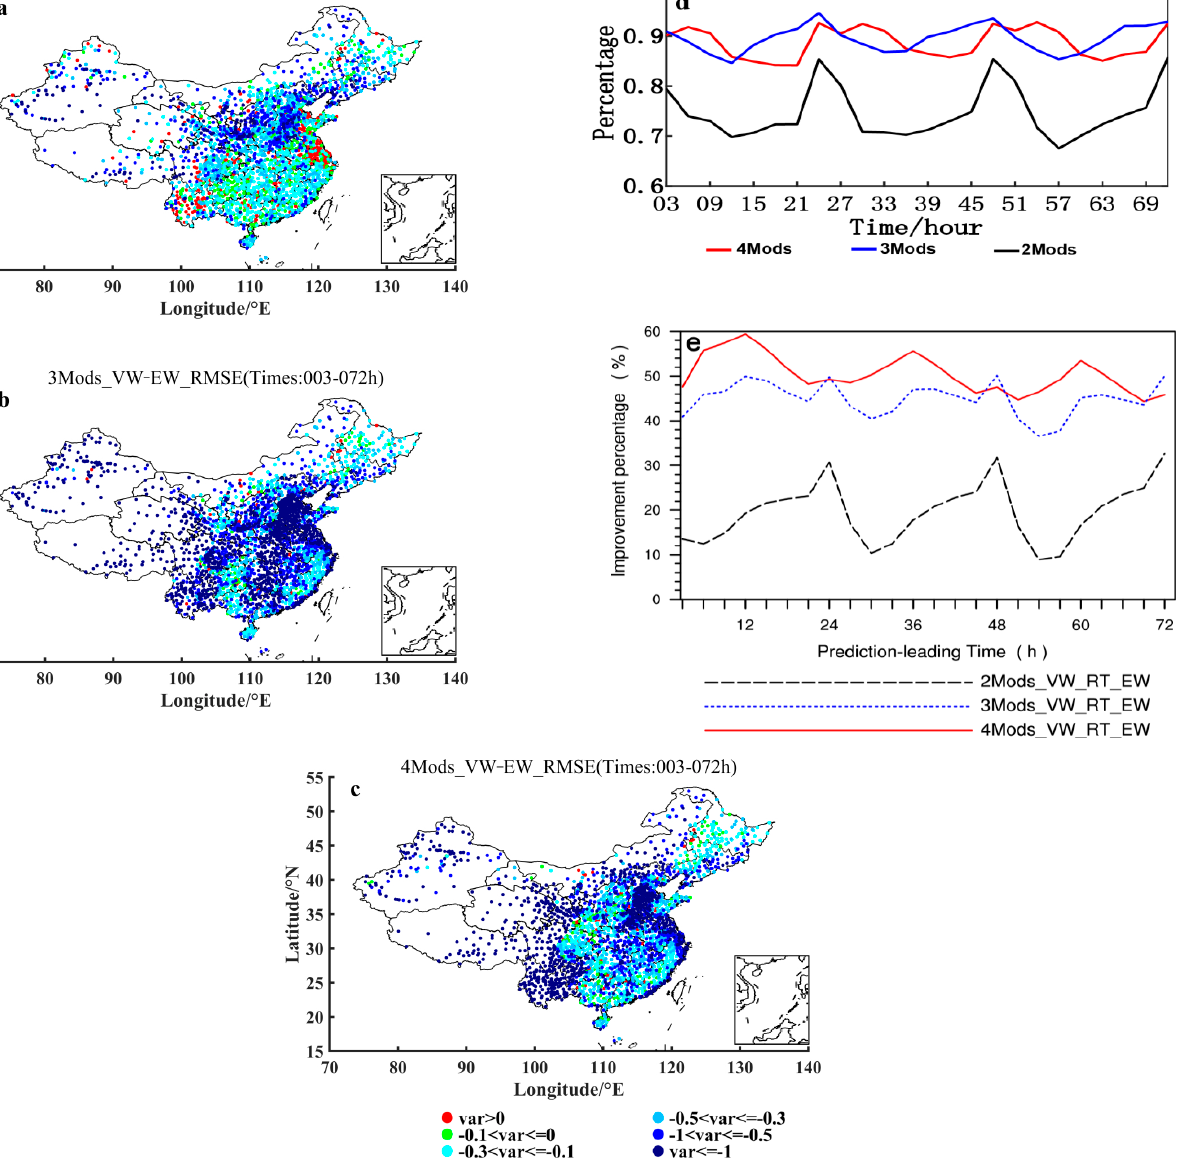
Figure 5. Distributions of the 2 m temperature prediction RMSEs difference (units: °C) between VW and EW ensemble methods for ( a ) 2-, ( b ) 3- and ( c ) 4-models ensemble forecasting. ( d ) Variations of the percentage of the stations, where the VW ensemble method produces lower 2 m temperature prediction RMSEs than the EW ensemble method, with respect to the various prediction leading times for the 2-, 3- and 4-models ensemble forecasting. ( e ) Variation of improvement percentage of the ensemble forecasting using VW methods relative to that using EW methods, with respect to the leading times. The models taken for the 2-, 3- and 4-models ensemble forecasting are shown in Table 1.